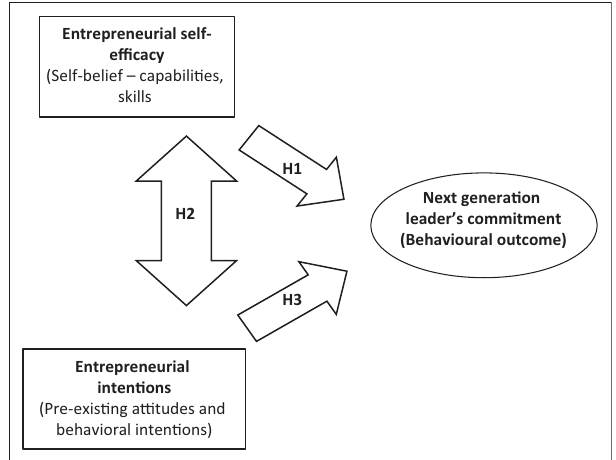
FIGURE 2: The proposed three-factor model of next-generation leaders’ commitment.